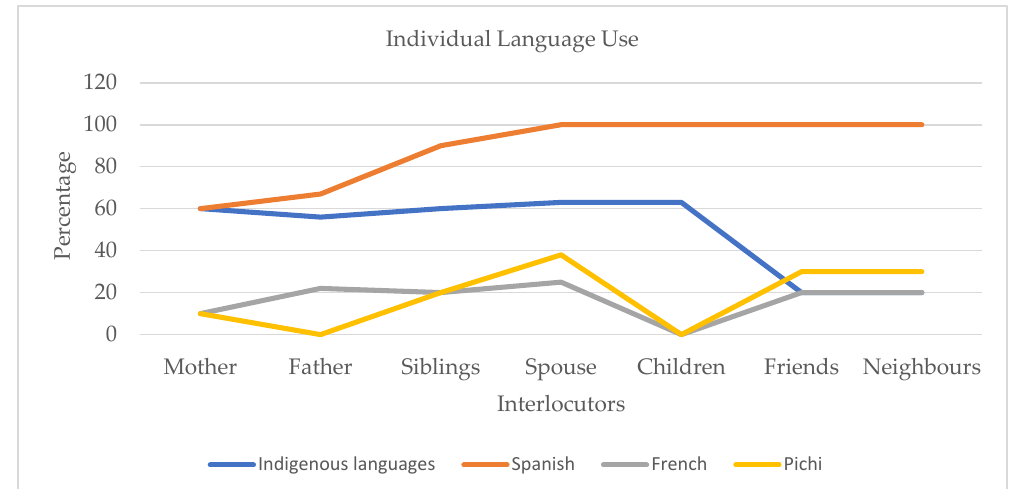
Figure 2. Use of Spanish and other languages with different interlocutors (%).